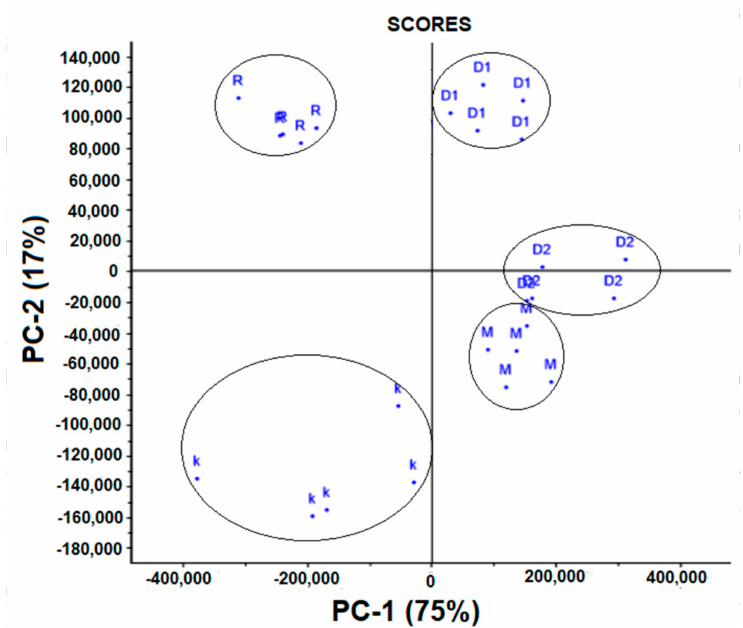
Figure 9. Principal component analysis (PCA) plot of the samples. The labels indicate the gypsum K = Kachchch; M = Acicular; D1 = Rajpura-Dariba 1; D2 = Rajpura Dariba 2; R = Desert